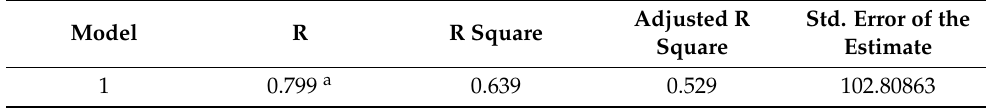
Table 6. Model Summary—Variable: Max Range . Model R